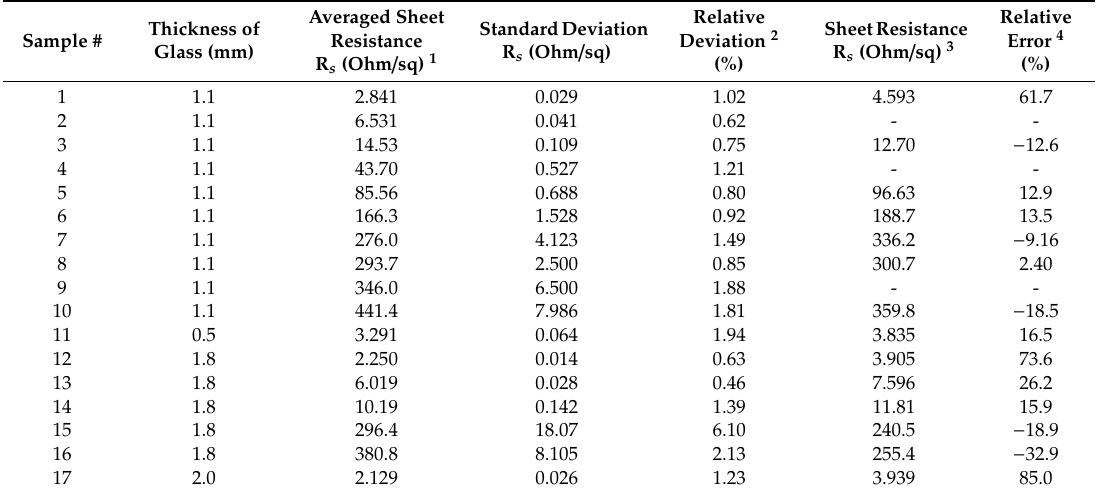
Table 1. Sheet resistance ( R 𝑠 ) of ITO samples measured using the four-point probe method and the microwave method.